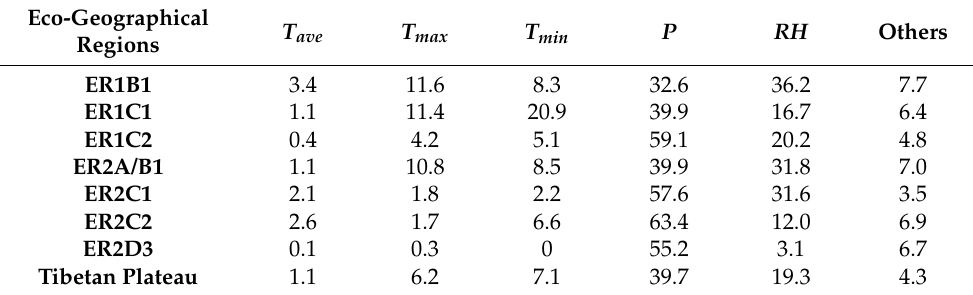
Figure 5. The effect regions of climatic determinants on NDVI on the Tibetan Plateau. “Others” means the role of non-hydrothermal factors. Table 4. Percentage of the area occupied by the effect regions of climatic determinants in ecoregions of the Tibetan Plateau